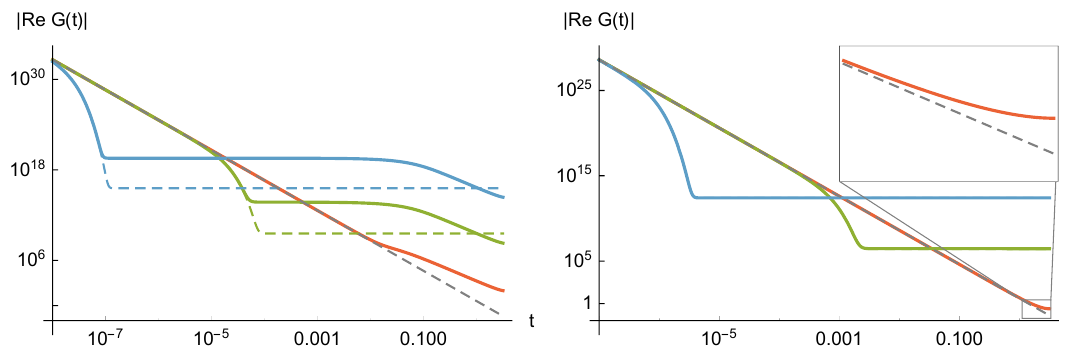
Figure 4 . d = 4. Left: vector model for (cid:12)=(cid:12) c = 10 (red), (cid:12)=(cid:12) c = 10 (cid:0) 3 (green) and (cid:12)=(cid:12) c = 10 (cid:0) 6 (blue). The solid lines correspond to the exact behavior, while the dashed lines illustrate the unconstrained theory. The gray dashed line depicts the vacuum correlator. The crossover times in the high temperature phase are in order of increasing temperature t a ’ 0 : 15 and 0 : 18. Right: adjoint model for the same values of (cid:12)=(cid:12) c . Line styles are as on the left. The crossover times are beyond the light crossing time of the